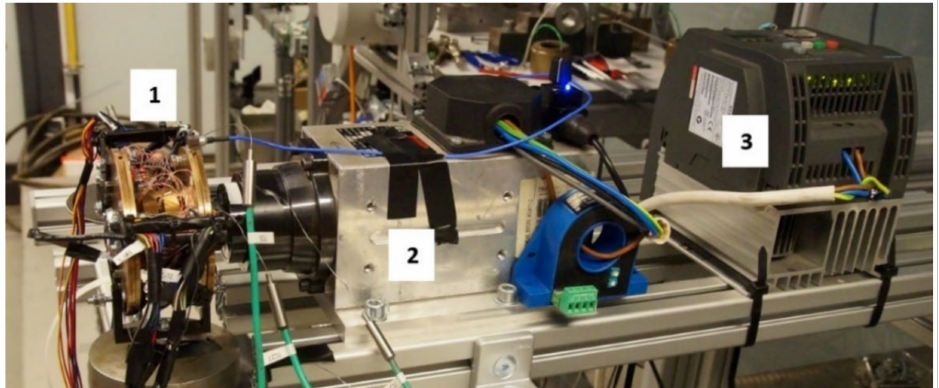
Figure 9. Close-up view of the bearing ( 1 ), electrospindle ( 2 ) and inverter ( 3